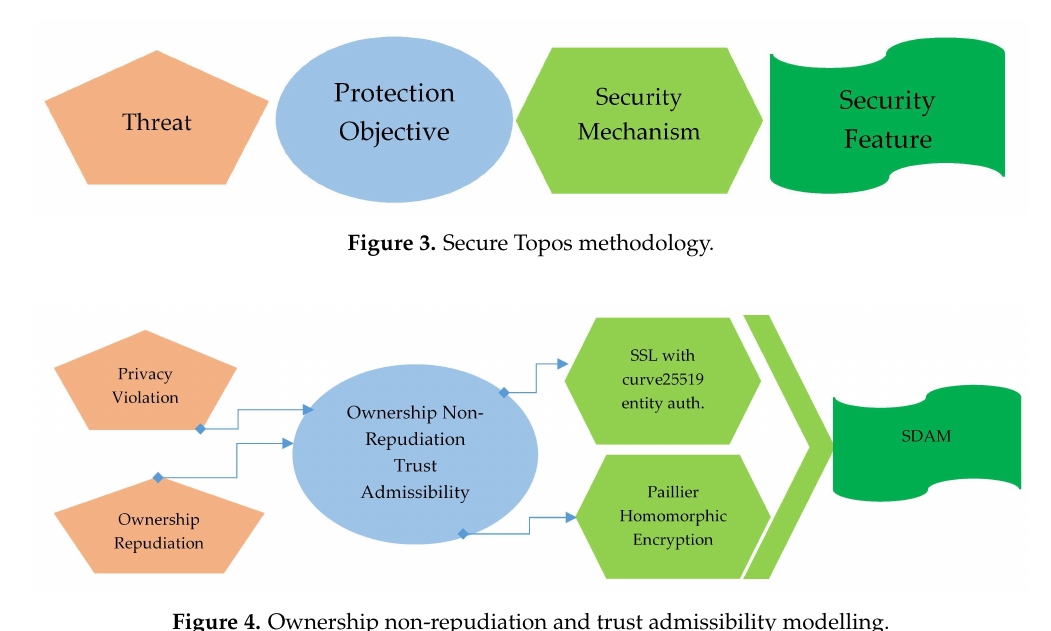
Figure 4. Ownership non-repudiation and trust admissibility modelling.